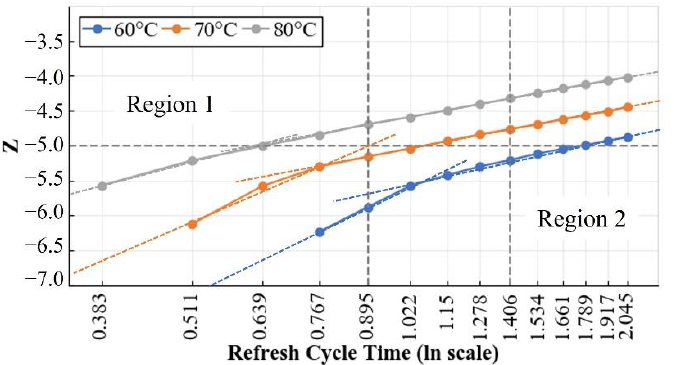
Figure 15. Z-value plot of retention errors with varying RCT at T L of 60 ◦ C, 70 ◦ C, and 80 ◦ C in Pseudo channel 0 of Channel 0.